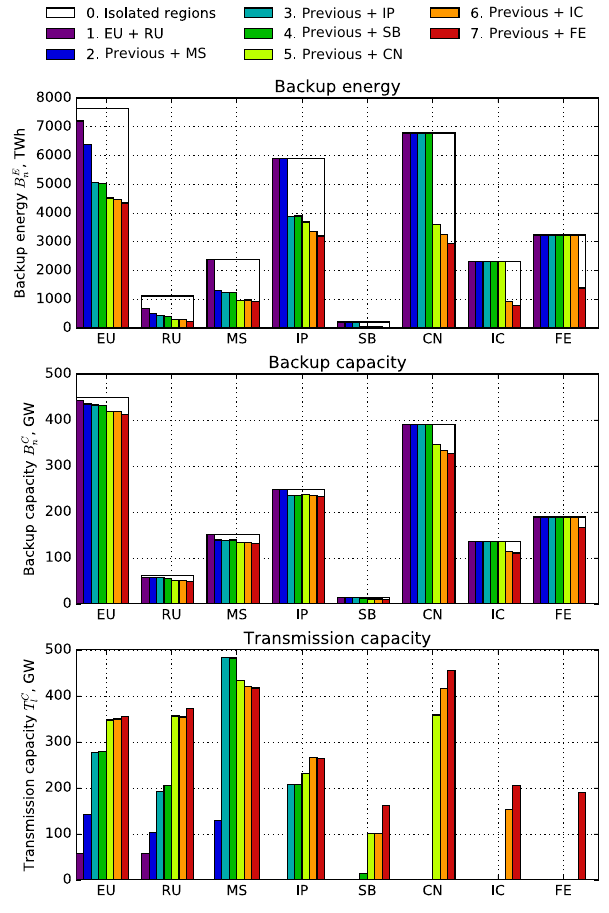
Figure 7. Need for backup energy, backup capacity and transmis- sion capacity of the Eurasian regions in dependency of the grid ex- pansion from west to east, α = 1. The node labels are listed in the order of connection to a